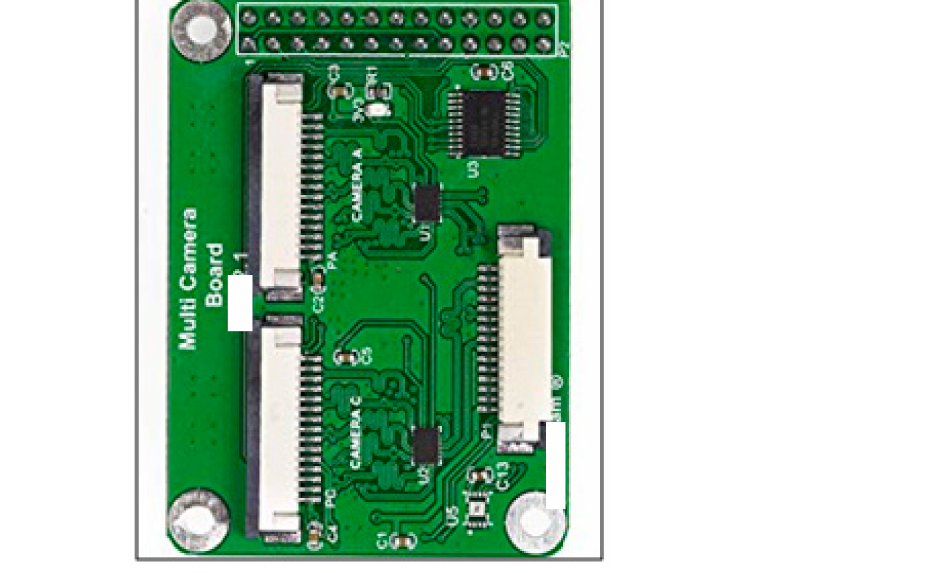
Figure 3. Multi Camera. Table 3. Specifications of Multi Camera.